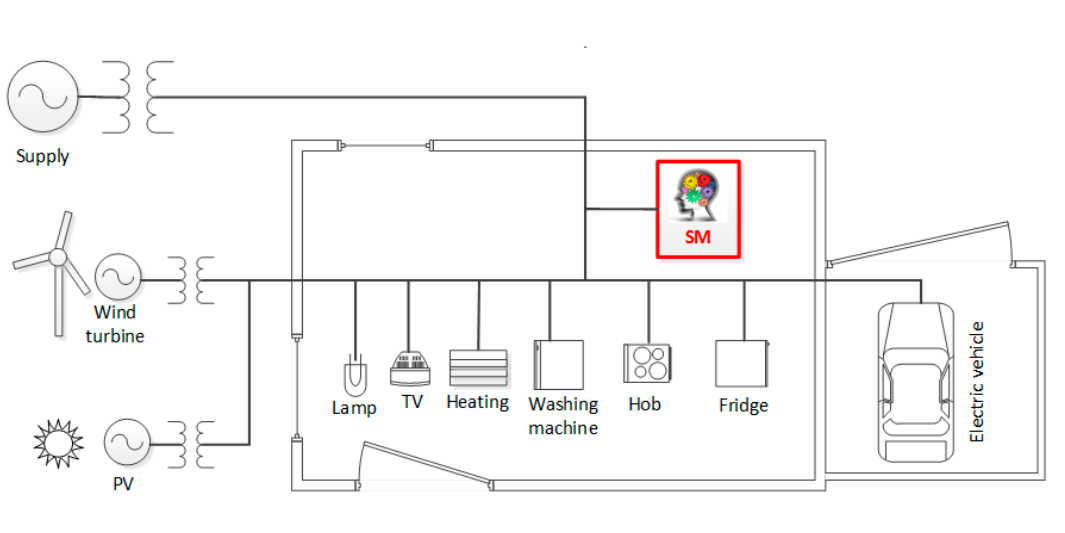
Figure 5. Smart meter role.